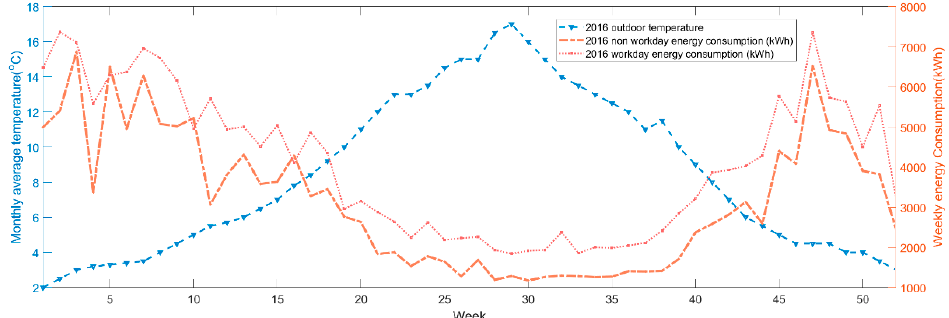
Figure 3. Jan 2010–Apr 2017 daily heat and electrical energy consumption (kWh).